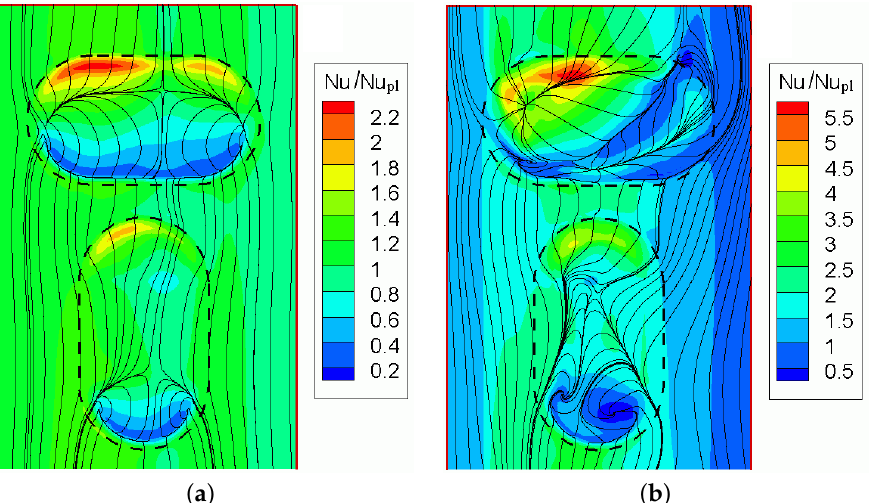
Figure 18. Comparison of relative Nusselt number fields on the lower wall of the dimpled channel with spreading patterns for depths of 0.1 ( a ) and 0.2 ( b ).